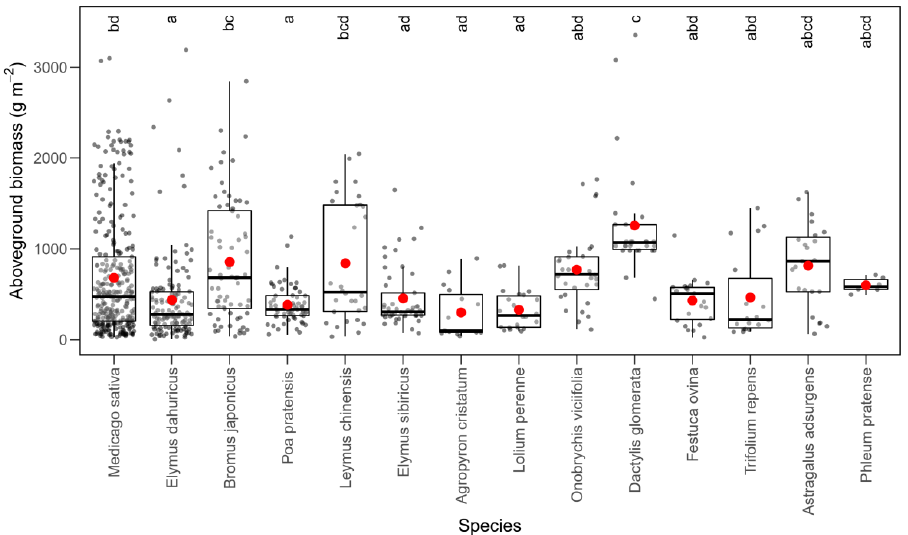
Figure 2. Observed AGB of different grass species planted in managed grasslands. Red dots show the average, and boxplots show the median and interquartile range with whiskers extending to 1.5 times the interquartile range. Different letters above the boxes indicate significant differences ( p < 0.05) between the AGB of different species. Regardless of other factors, such as species and water management, AGB under fer- tilization (e.g., nitrogen, phosphorus, and potassium) was on average 50% higher than that under zero fertilization (Figure 3a). Similarly, the adoption of irrigation enhanced the average AGB by approximately 100% compared with that under rainfed conditions (Figure 3b). When pooling all data together, we found that AGB was generally higher in regions with higher mean temperatures during the plant growing seasons (i.e., April – October; Figure A3a), while the correlation between AGB and P G (accumulated precipitation during the growing season) was much weaker (Figure A3b). By excluding the impacts of fertilization and irrigation, we found that the AGB of Medicago sativa , for example, was generally higher in regions with a warmer and wetter growing season (Figure 3c,d).